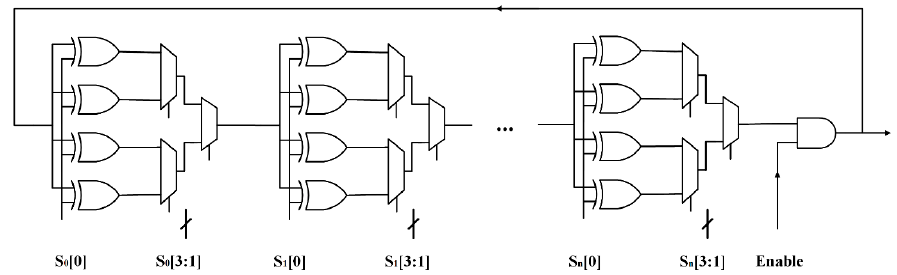
Figure 6. Architecture of the proposed configurable RO.